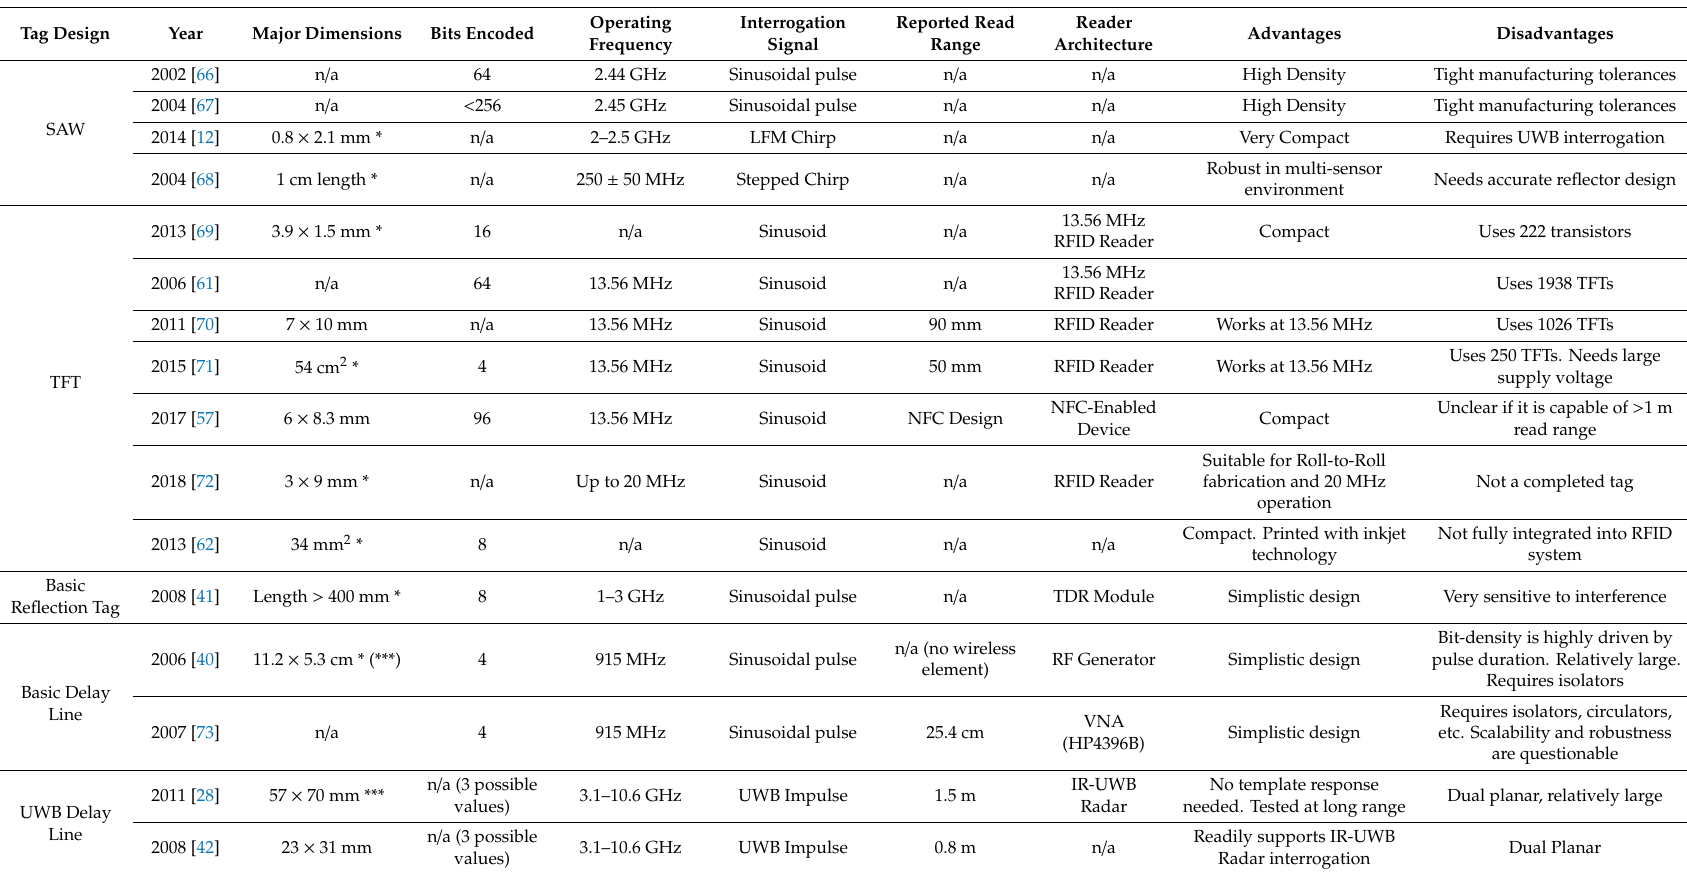
Table 1. Time Domain Tag